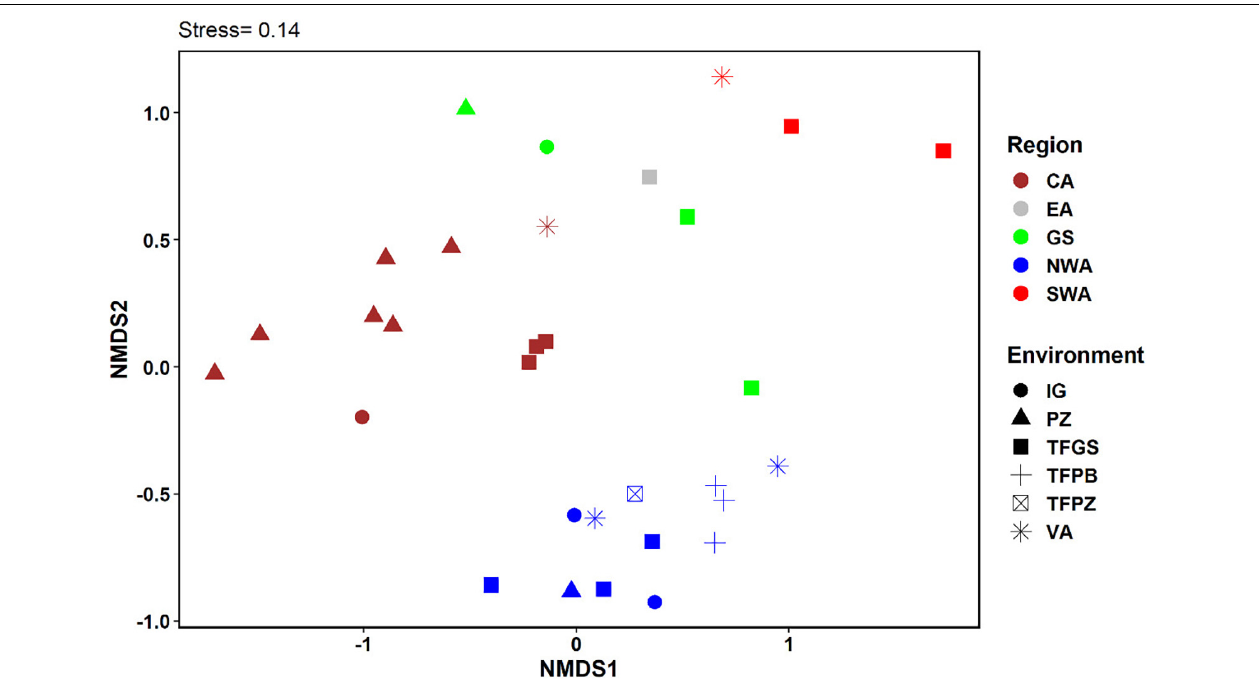
FIGURE 5 | The first two axes of a Non-metric Multidimensional Scaling (NMDS) illustrating VEA compositional structure across the Amazon Basin. Colors represent biogeographical regions and symbols represent